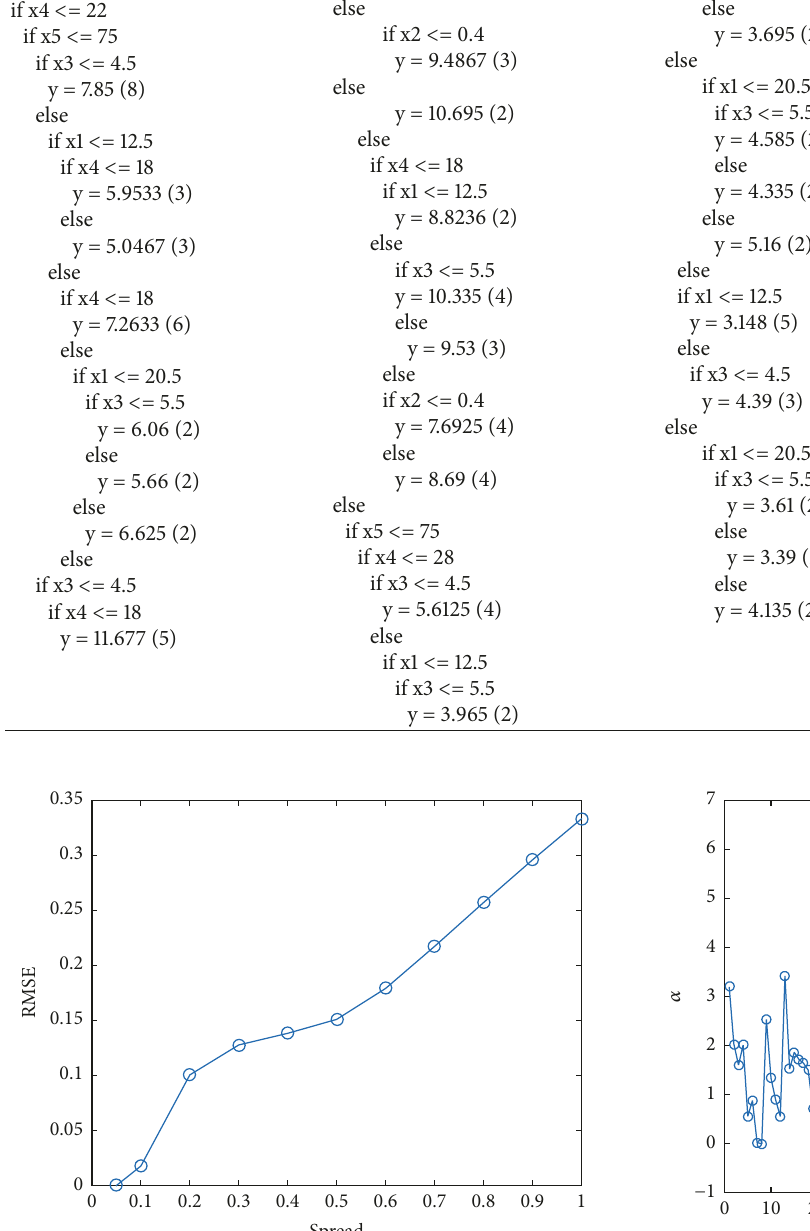
are reported to be 0.03, 0.366 cm, and 0.316 cm, respectively. The SVR model outperformed the above three models in the training and testing data sets with The R 2 , RMSE, and MAE values being 0.001, 0.052 cm, and 0.036 cm, respectively. Also, the slopes of linear fitting for this model for the predicted and d values in the training and testing phases are almost equal (0.99). From these results, the maximum changes for the RMSE and MAE are reported with the M5Tree and GRNN models. Based on the presented discussion, it is noted that the MARS and SVR models outperformed the M5Tree